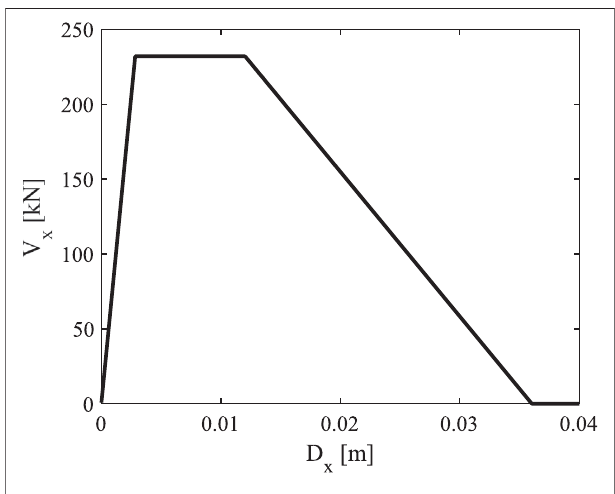
FIGURE 7 | Force-displacement trilinear backbone of the dowel connection.